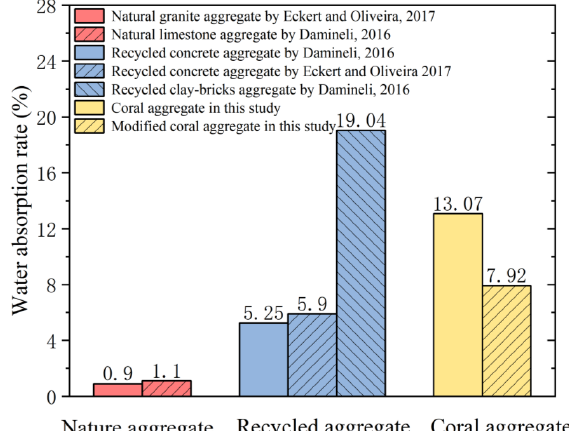
Figure 5. Effect of W/C of cement on water absorption of coral aggregates.